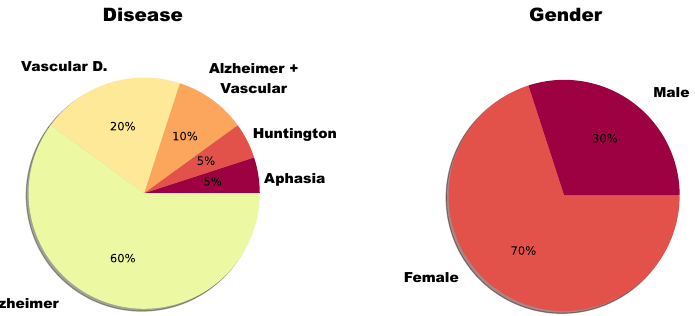
Figure 5. Distribution by diagnosis and by gender of the people who participated in the study. ( left ):population disease distribution; ( right ): gender